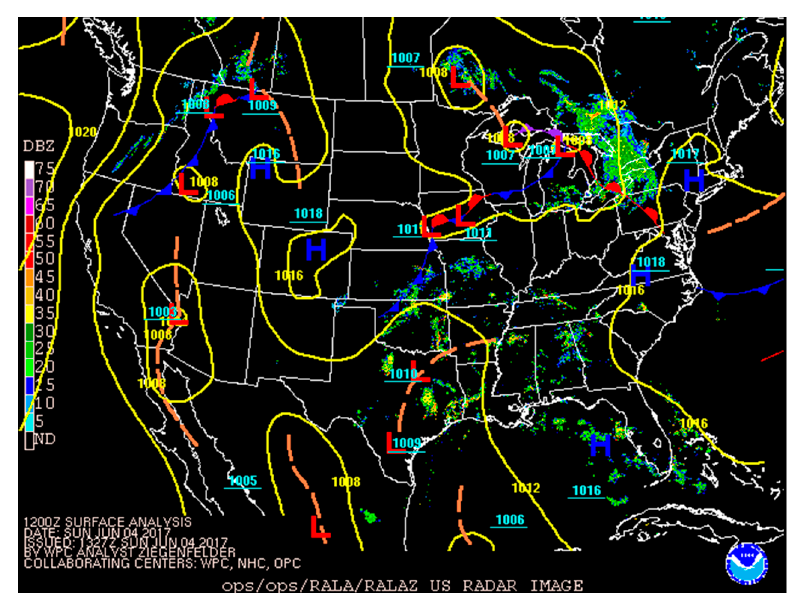
Figure 10. Radar composite map of 4 June, with 12Z showing the presence of a high-pressure ridge on the northern part of Texas. Source: National Weather Service’s (NWS) Weather Prediction Center (WPC) Surface Analysis Archive.